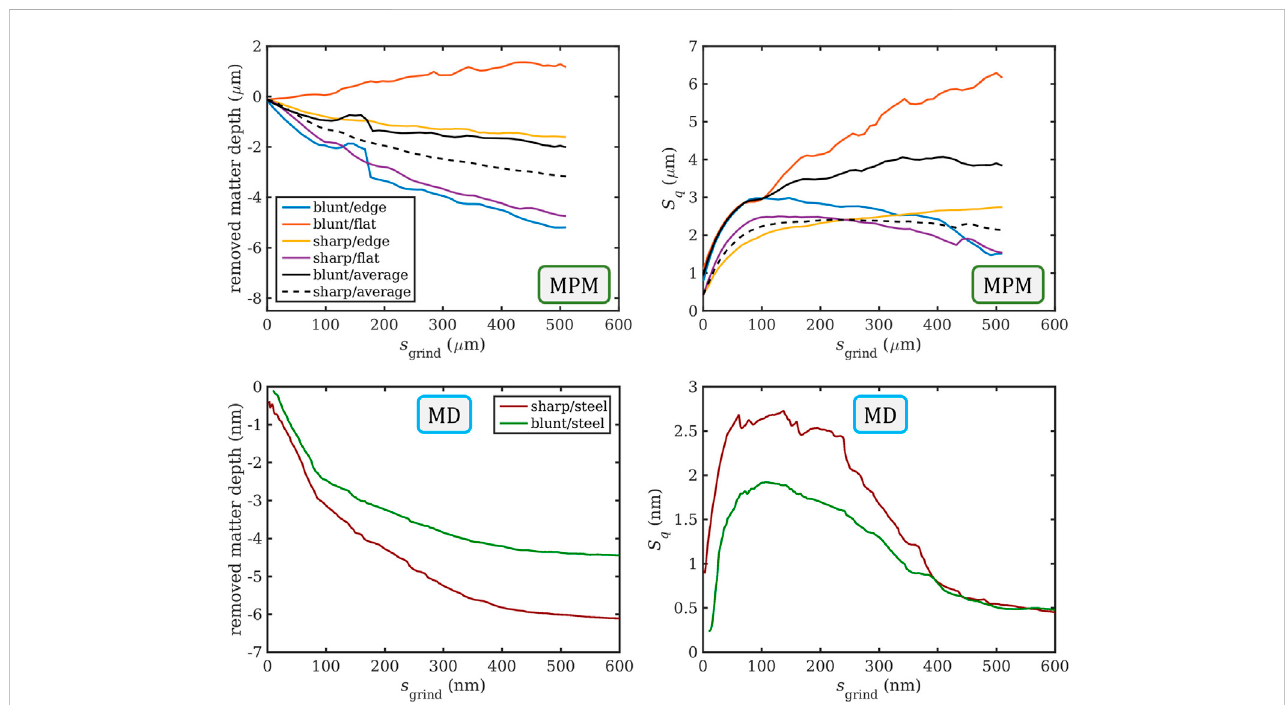
FIGURE 8 Removed matter depth and RMS roughness ( S q ) as functions of the grinding distance for the four abrasive con fi gurations studied using MPM, including trends that were averaged over the two extreme orientations (top), compared to similar MD simulations of grinding steel, scaled down by a linear factor of 1000, with data taken from Ref. (Eder et al., 2022).